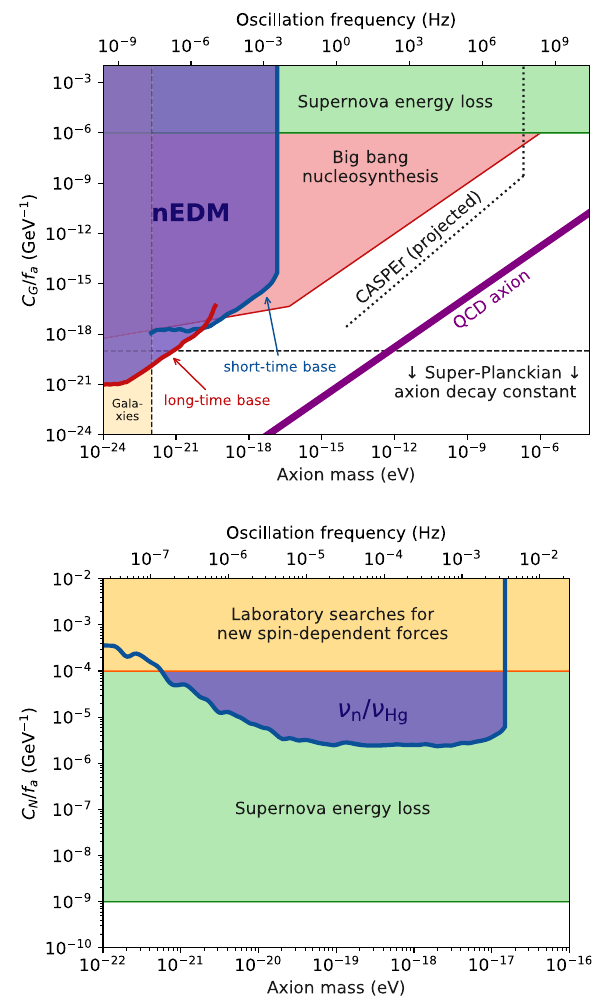
FIG. 4. Limits on the interactions of an axion with the gluons (top) and nucleons (bottom), as defined in Eq. (1), assuming that axions saturate the local cold DM content. The regions above the thick blue and red lines correspond to the regions of parameters excluded by the present work at the 95% confidence level (C.L.). The colored regions represent constraints from big bang nucleo- synthesis (red, 95% C.L.) [36 – 38], supernova energy-loss bounds (green, order of magnitude) [35,39,40], consistency with obser- vations of galaxies (orange) [15,25 – 27], and laboratory searches for new spin-dependent forces (yellow, 95% C.L.) [41]. The = ν nEDM, ν , and big bang nucleosynthesis constraints scale as p ffiffiffiffiffi n Hg ∝ ρ , while the constraints from supernovae and laboratory a searches for new spin-dependent forces are independent of ρ The constraints from galaxies are relaxed if axions constitute a subdominant fraction of DM. We also show the projected reach of the proposed CASPEr experiment (dotted black line) [86], and the parameter space for the canonical QCD axion (purple